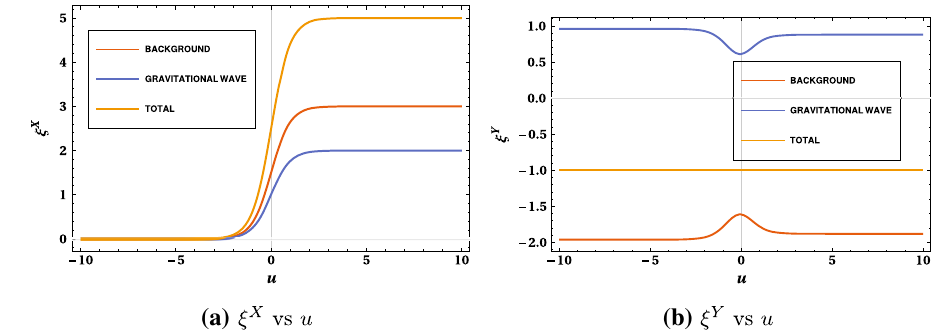
Fig. 3 Plot of deviation vectors along the coordinates X and Y for ω = −